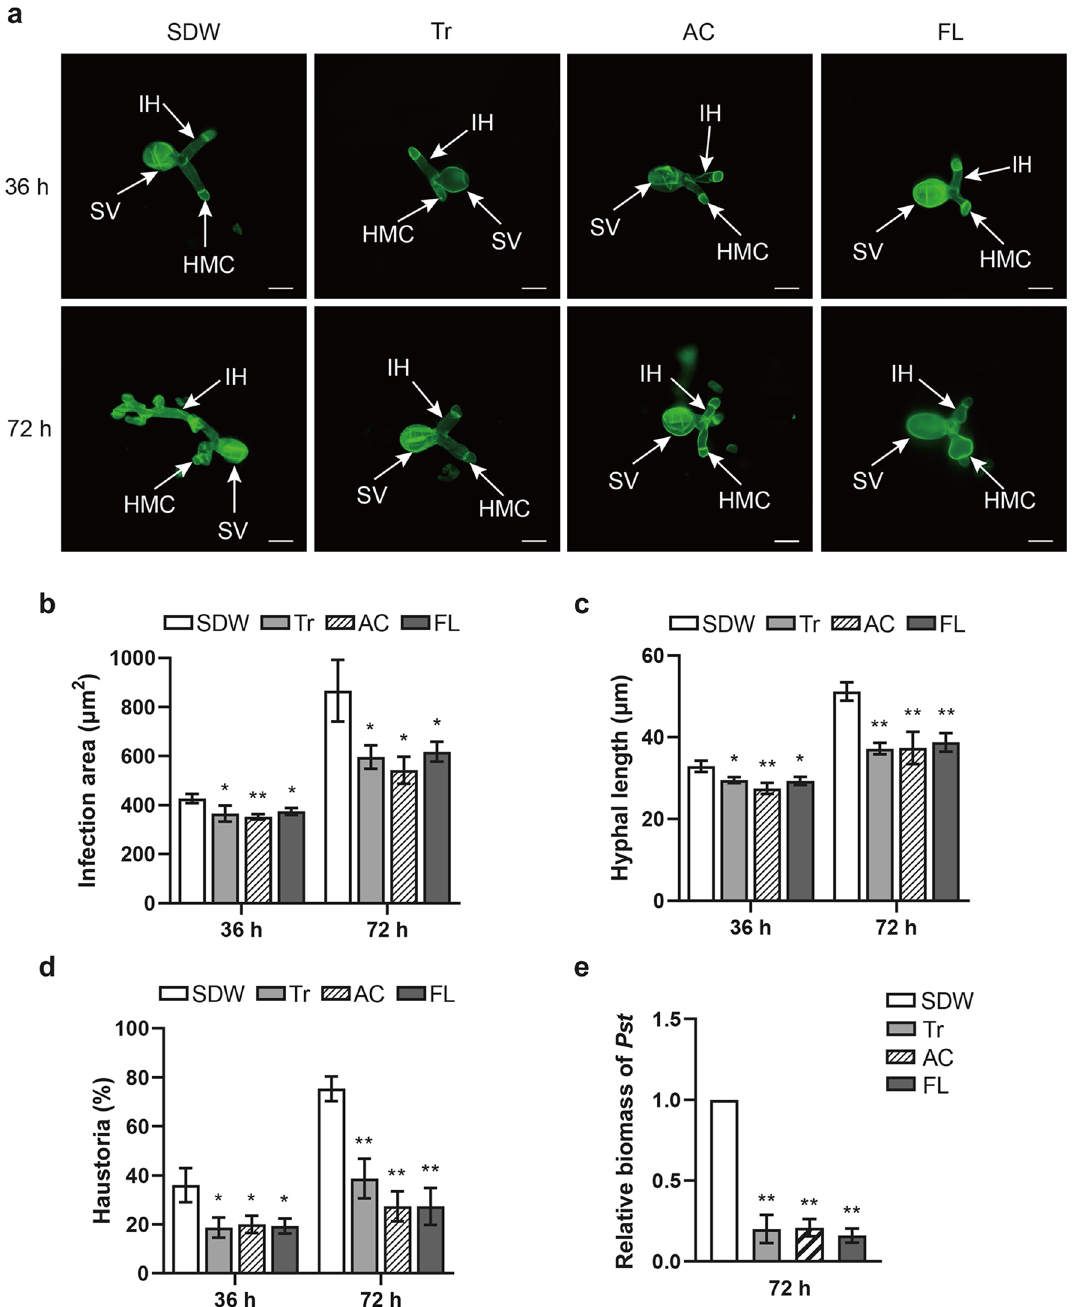
Fig. 3 Effects of XF on Pst growth in leaves. a Histological observation of fungal growth in wheat. SV, substomatal vesicle; IH, infectious hyphae; HMC, haustorial mother cell. Bars 20 μm. b Infection area, the average area of the expanding hypha plus the host cells, was calculated by CellSens = Entry software. c Hyphal length is the average distance from the junction of the substomatal vesicle and the hypha to the tip of the hypha. d Haustoria formation rate of Pst with various treatments. e RT-qPCR analysis of the relative expression levels of PstEF in leaves at 72 h after inoculation with Tr, AC, and FL. TaEF and PstEF were used to normalize the RNA level of wheat leaves and Pst , respectively. SDW, sterile distilled water; Tr, 20% triadimefon emulsions at a concentration of 0.5 g/L; AC, XF actinomycete cell suspension (10 7 CFU/mL); FL, XF fermentation liquid without actinomycete cells. Values in charts are mean SD. An asterisk indicates significant differences based on the unpaired two-tailed Student’s t -test ± with the P values marked (* P < 0.05; ** P < 0.01) between the SDW treatment and other